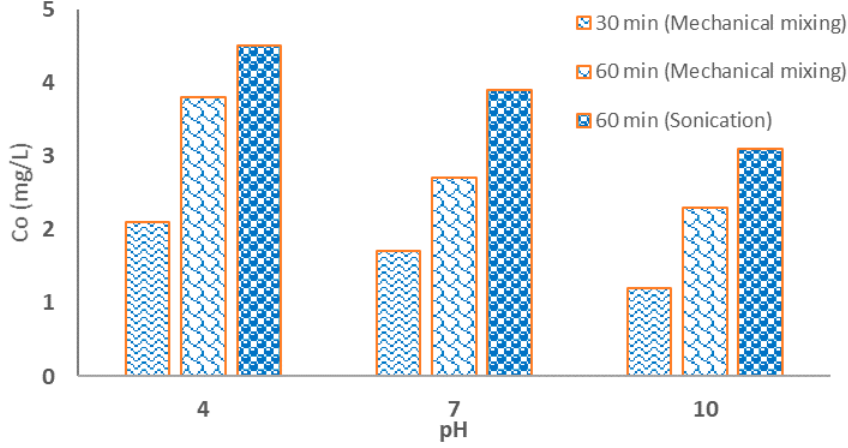
Figure 7. Leaching of Co from ZIF-67-SO 4 structure as a function of time, pH, and mixing type.